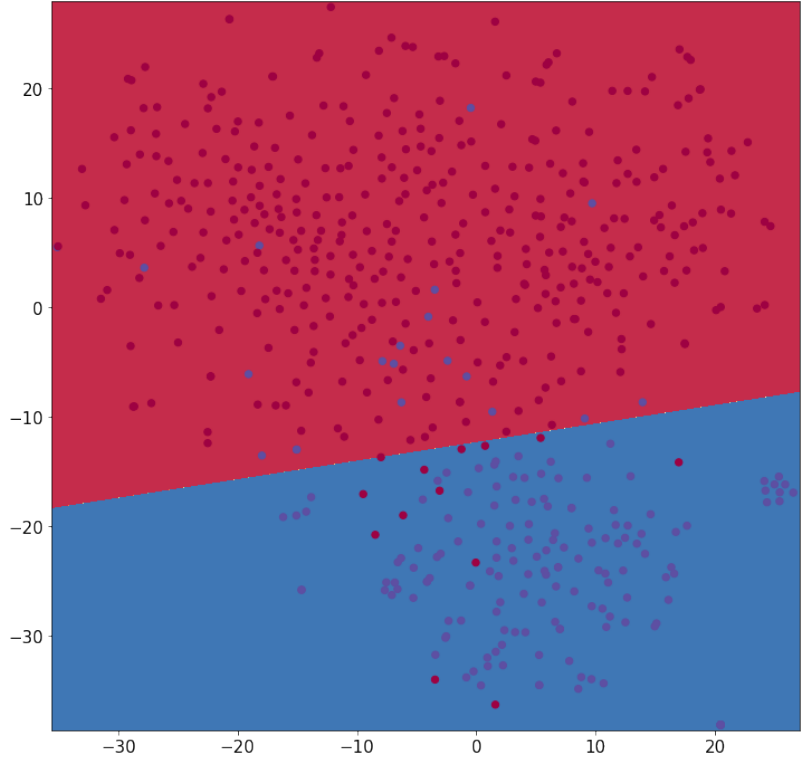
Figure 3. A linear classification plot based on our Las Vegas case study experiments. The blue points represent tweets relevant to the Las Vegas crisis (positive tweets), while the red points are irrelevant to the crisis (negative tweets). Note that the active learning method would not have access to this information and would pick the points closest to the line as the ‘uncertain’ data for the next